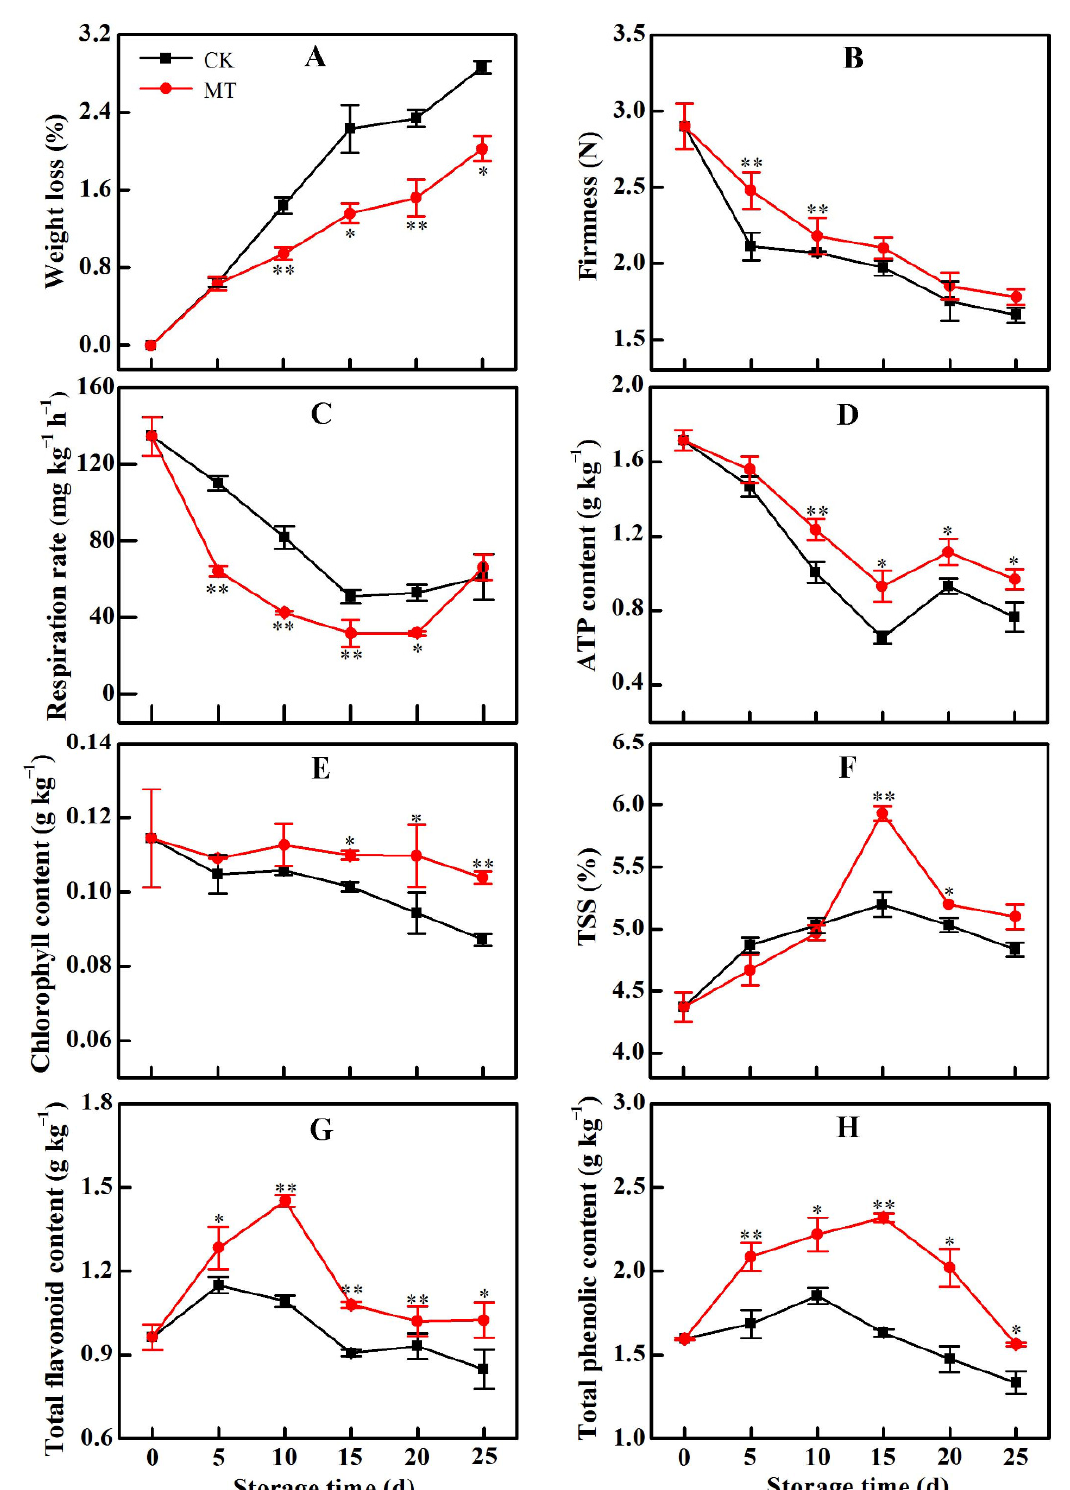
Figure 2. Change in weight loss rate ( A ), fruit firmness ( B ), tissue respiration rate ( C ), cellular ATP content ( D ), chlorophyll content ( E ), total soluble solids (TSS) content ( F ), flavonoid content ( G ) and total phenolic content ( H ) of pepper fruit during cold storage after treatment with water (CK) or melatonin (MT). Asterisks * and ** indicate the significant differences ( p < 0.05 or p < 0.01, respectively) between treatments.